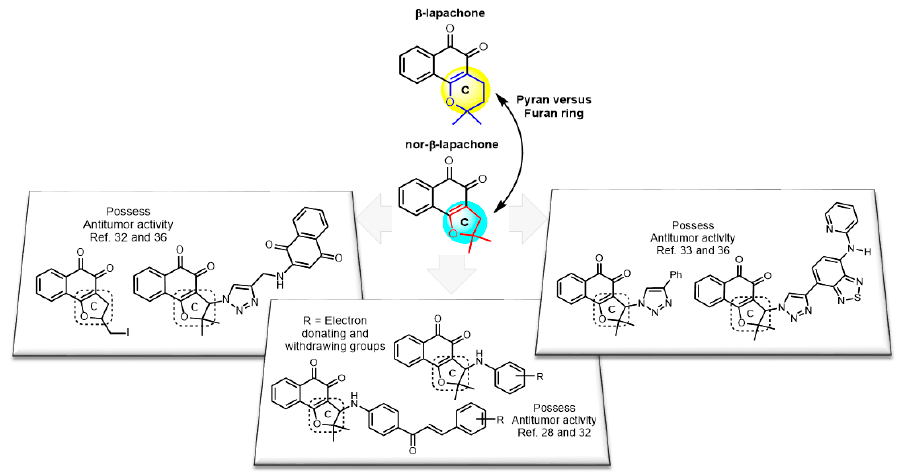
Scheme 1. Structural modifications of the prototype nor- β